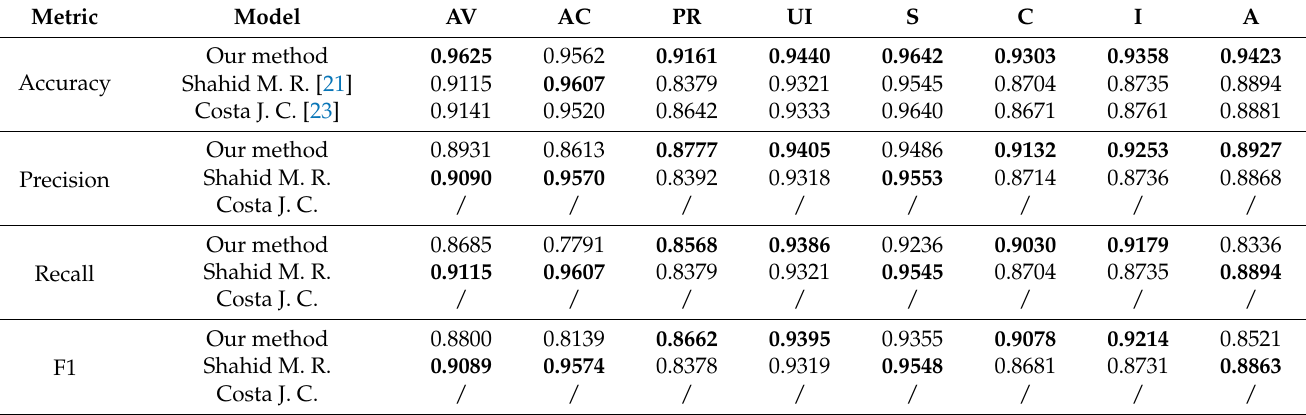
Table 8. Comparison of related methods on the CVSS v3.1 dataset.